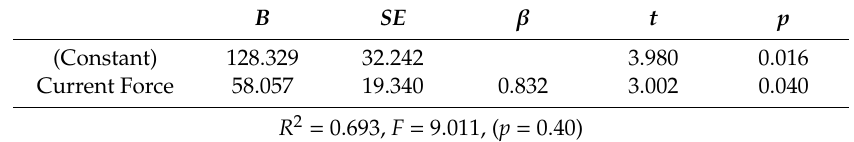
Figure 11. Relationship between track deviation and current force: ( a ) flood current; ( b ) ebb current. Table 1. Relationship between track deviation and current force in flood current. SE, standard error.